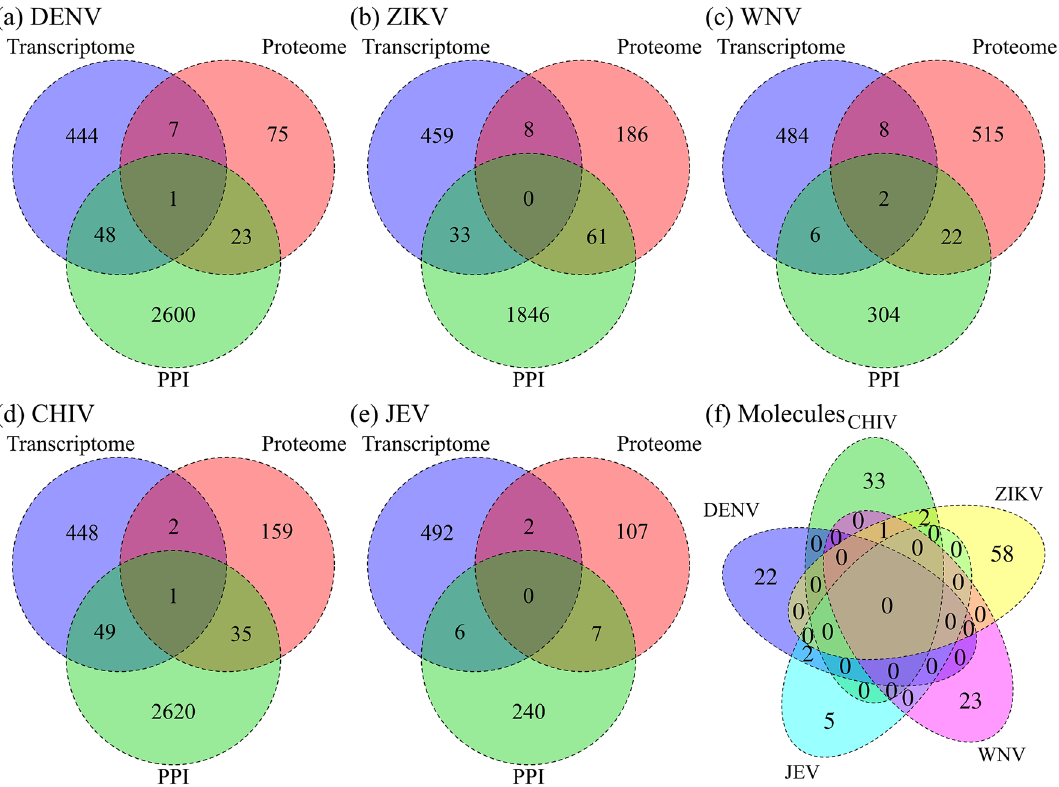
Figure 2. Signature genes and proteins by multiple omics analyses. Venn diagrams show the overlap of signature genes and proteins by multiple omics analyses for the five viruses: ( a ) DENV, ( b ) ZIKV, ( c ) WNV, ( d ) CHIV and ( e ) JEV. The number of signature genes obtained from transcriptomic data with significant differences is shown in the blue circle for infections. The number of signature proteins obtained from proteomics data is shown in the orange circle. The number of human proteins that interact with viral proteins in human– virus PPIs is shown in the green circle. ( f ) Venn diagram of common signature proteins, which represent the intersection between proteome and PPIs for the five viral infections. The total number of the unique proteins was 146 for the five viral Drug candidates by multiple omics analyses. We identified drug candidates for each infection based on omics analyses. From transcriptomic analysis, the 300 most upregulated and the 300 most downregulated signature genes for the five diseases obtained from GEO data sets that were compatible with the HG-U133A plat- form of CMap were used to query the CMap system. The rank matrix of CMap was built by fold change based on differential expression profiles. The up- and downregulated genes selected by fold change were used as differen- tially expressed signature genes for drug repositioning. STITCH 5.0 was used to search for drug candidates that interact with the signature proteins from proteomes and human–viral PPIs. Figure 4a–e shows drug candidates from multiple omics analyses. For DENV, 588 compounds with statistical significance ( p < 0.1) using the CMap permutated results were identified as the union of each dataset (GSE50698: 125; GSE23986: 100; GSE51808: 119; GSE34628: 22; GSE9378: 118; GSE18090: 128; GSE40628: 161; GSE38246: 160; GSE25226: 78; GSE58278: 67). By searching STITCH for drug candidates based on the proteomic data, we found 293 drug candidates that interacted with 106 significant proteins. For drug candidates from the interactomic data, we found 1,641 drug candidates in STITCH that interacted with 2672 human proteins identified in the human–viral PPIs. Finally, 58 drug candidates were identified that overlapped over the analyses of the three layers. For ZIKV, 118 compounds were identified using the CMap as GSE98889. Four-hundred and twenty-nine drug candidates interacted with 255 significant proteins, and STICH identified 1711 drug candidates that interacted with 1940 human proteins in PPIs. Eight drug candidates were shared over the analyses of the three layers. CMap detected 171 compounds as the union of each dataset (GSE46681: 104; GSE30719: 117) for WNV. Here, 564 drug candidates interacted with 547 significant proteins and STITCH identified 951 drug candidates that interacted with 334 human proteins in PPIs. Thirty-one drug candidates were shared over the analyses of the three layers. For CHIV, 89 compounds were identified as GSE49985. Two-hundred and ninety-four drug candidates interacted with 197 significant pro- teins and 1605 drug candidates were identified by STITCH to interact with 2705 human proteins in PPIs. Finally, we identified 12 drug candidates that were shared over the analyses of the three layers. For JEV, 93 compounds were identified as GSE57330. Three-hundred and three drug candidates interacted with 116 significant proteins and 866 drug candidates interacted with 253 human proteins in PPIs. Ten drug candidates were detected over the analyses of the three layers.